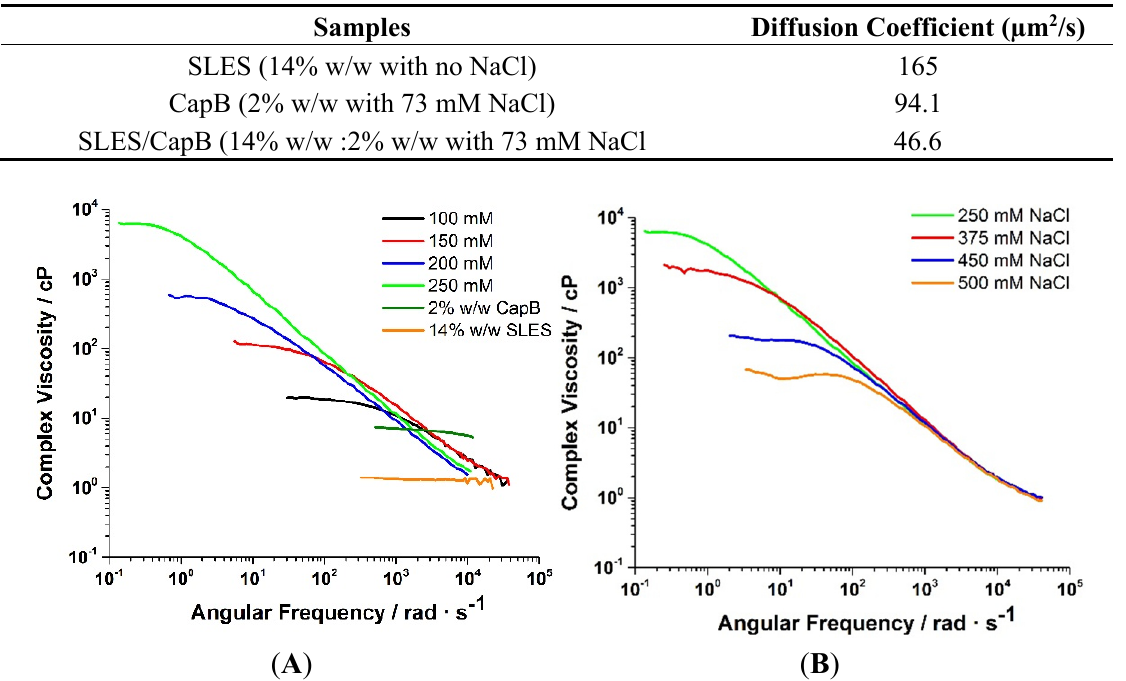
Table 1. Diffusion coefficients associated with surfactant mixtures.